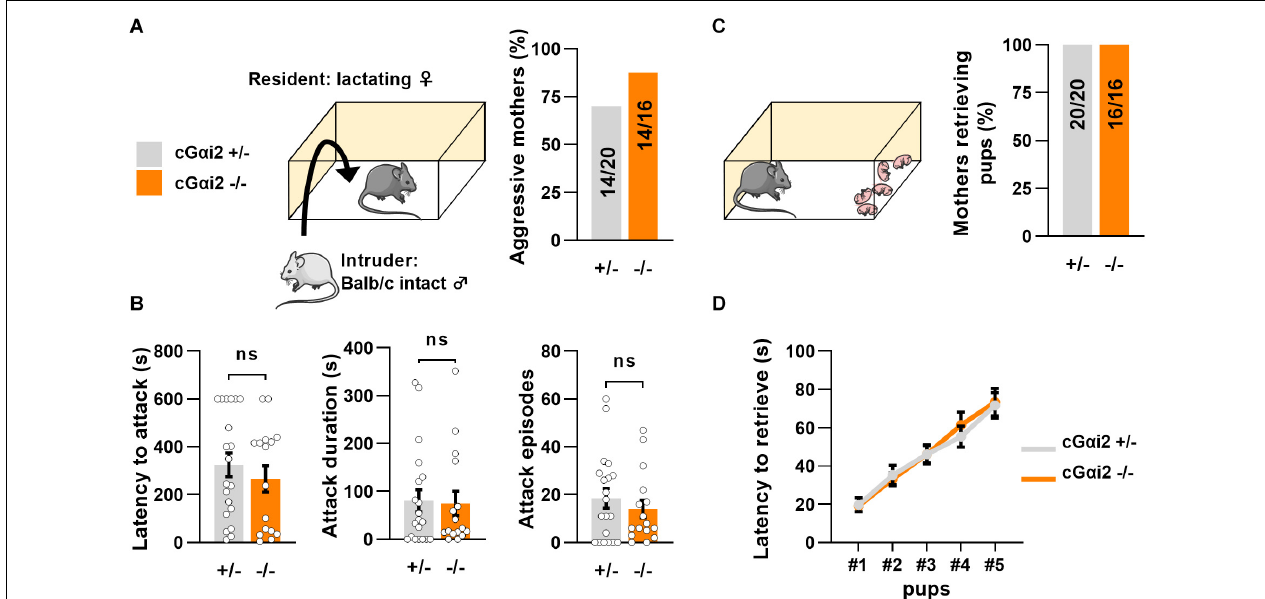
FIGURE 2 | Loss of G α i2 does not affect maternal behavior in lactating females. (A) Maternal aggression in lactating cG α i2 + / − ( N = 20) vs. cG α i2 − / − ( N = 16) females during three consecutive exposures to an intact male intruder in the resident-intruder test. 70% of cG α i2 + / − and 87% of cG α i2 − / − females present at least one aggressive episode (Fisher’s exact test: P = 0.3). (B) Measure of the aggression parameters latency to attack ( left ), cumulative attack duration ( middle ) and attack episodes ( right ) across genotypes (Mann-Whitney: P = 0.4–0.9). (C) 100% of cG α i2 + / − ( N = 20) and cG α i2 − / − ( N = 16) mothers retrieve five of their pups previously dispersed in the cage. (D) The latency to retrieve pups does not differ between groups (Dunn’s multiple comparison tests cG α i2 + / − vs. cG α i2 − / − for each pup’s latency P >